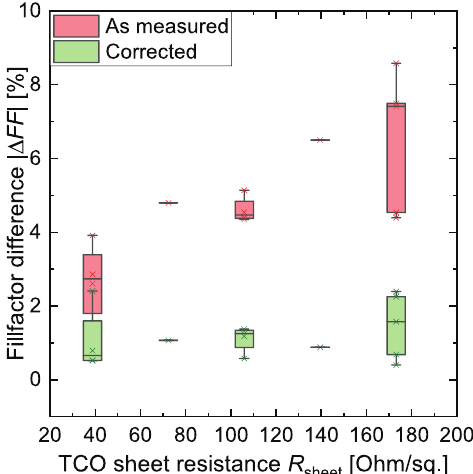
Fig. 10. Absolute difference of the FF measured by the 12 and 30 wire system compared to absolute difference after correction according to